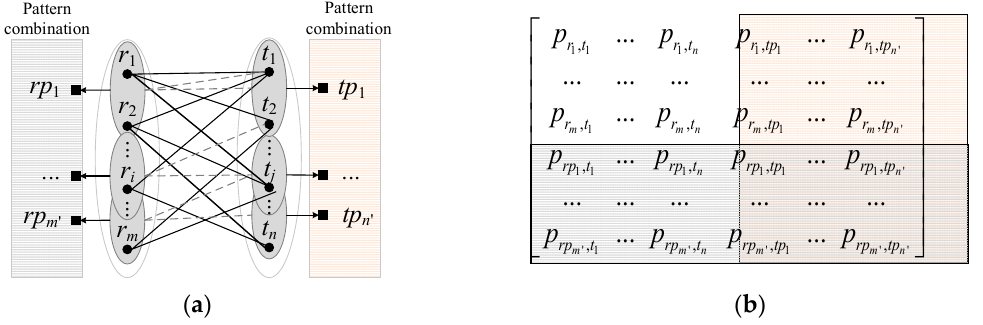
Figure 2. The relaxation labelling matching model in consideration of individual objects and pattern combinations: ( a ) graphical representation; ( b ) matrix representation.